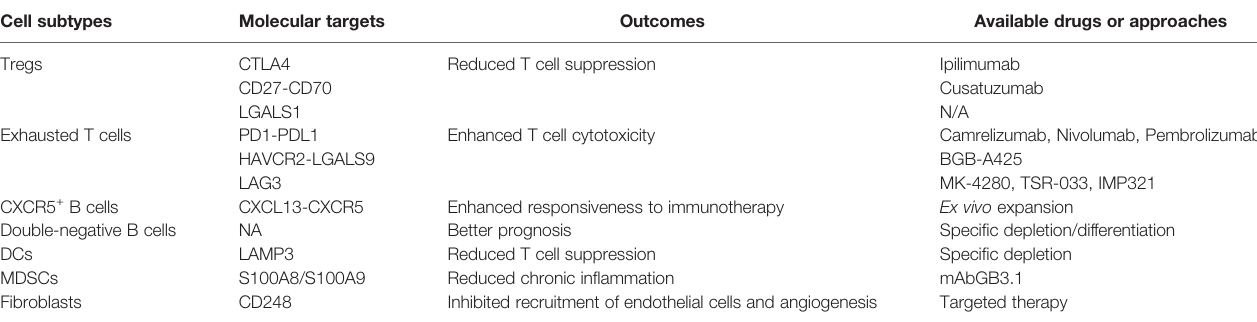
TABLE 2 | Proposed therapeutic approaches to target tumor-in fi ltrating cell subtypes in the NPC microenvironment. Cell